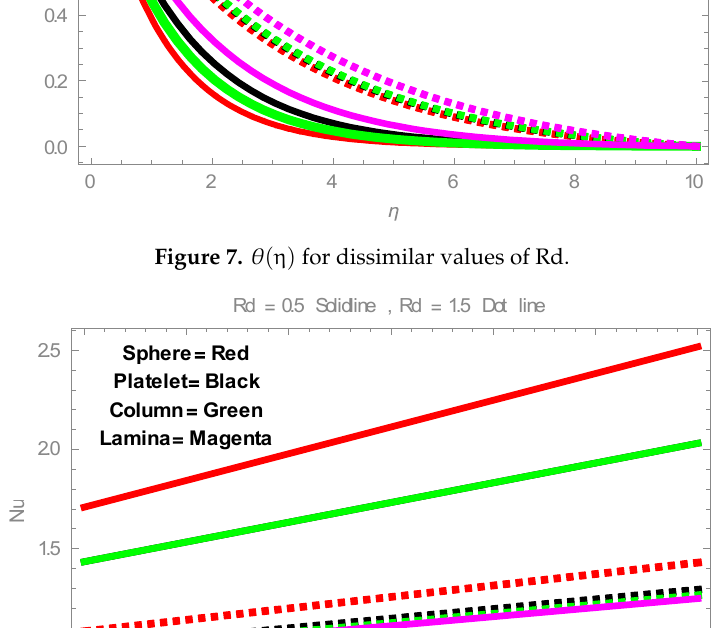
Processes 2020 , 8 , x FOR PEER REVIEW Figure 8. Nu for dissimilar values of (cid:1844)(cid:1856) . Figure 8. Nu for dissimilar values of Rd. Figure 8. Nu for dissimilar values of (cid:1844)(cid:1856) .